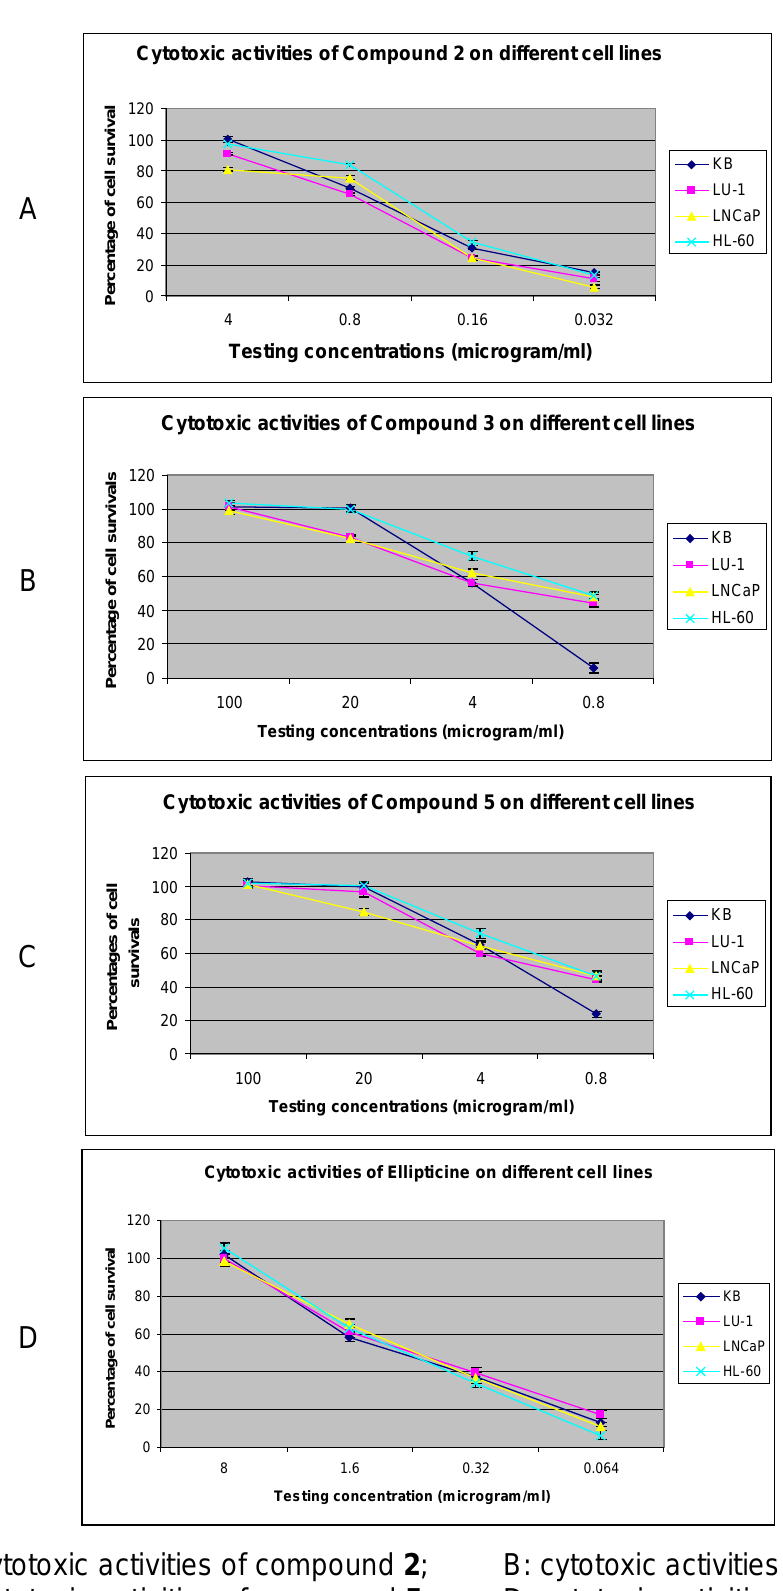
Fig. 2. A: cytotoxic activities of compound 2 ; B: cytotoxic activities of compound 3 ; C: cytotoxic activities of compound 5 ; D: cytotoxic activities of